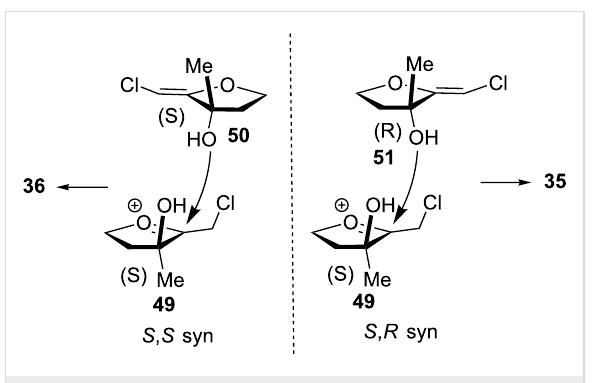
Scheme 10: Formation of a bridged dimer and a triene.